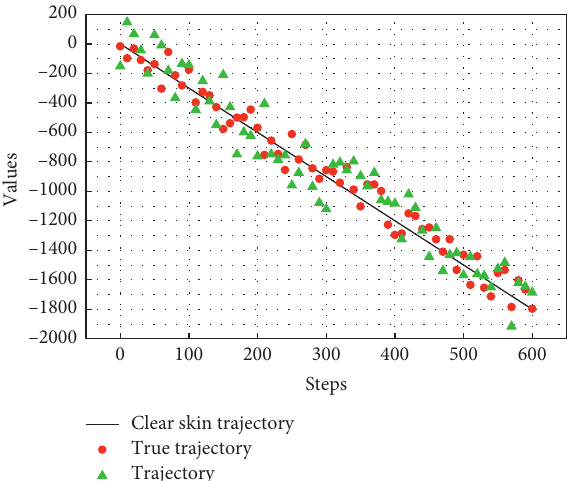
Figure 11: The number of people in a complex